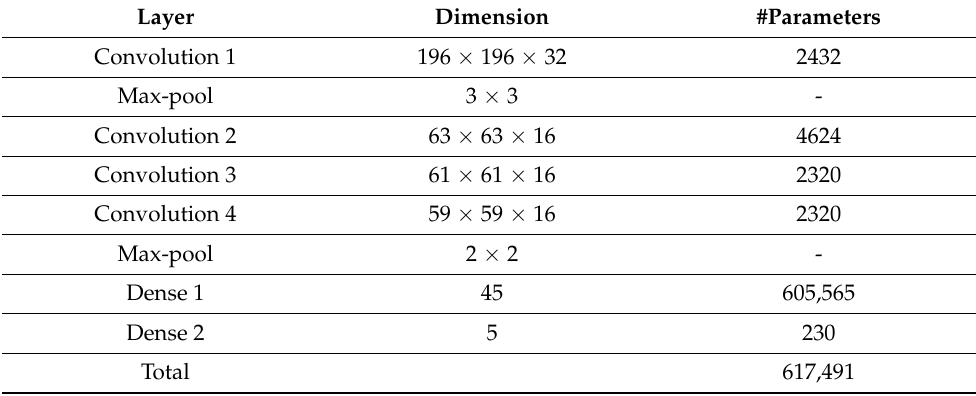
Table 1. Number of parameters used in the various levels of the CNN architecture for the presented design.